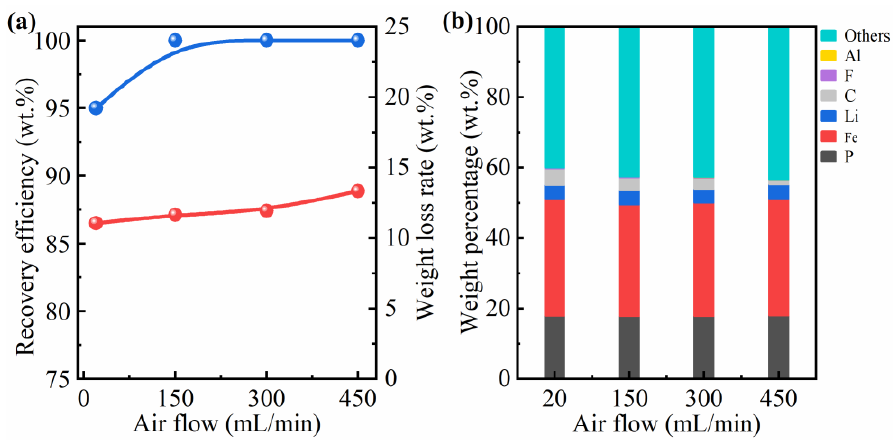
Figure 10. E ff ect of air flow on the ( a ) recovery e ffi ciency of cathode materials, weight loss rate of Figure 10. Effect of air flow on the ( a ) recovery efficiency of cathode materials, weight loss rate of cathode plates, and ( b ) element content in calcined cathode materials. cathode plates, and ( b ) element content in calcined cathode materials.